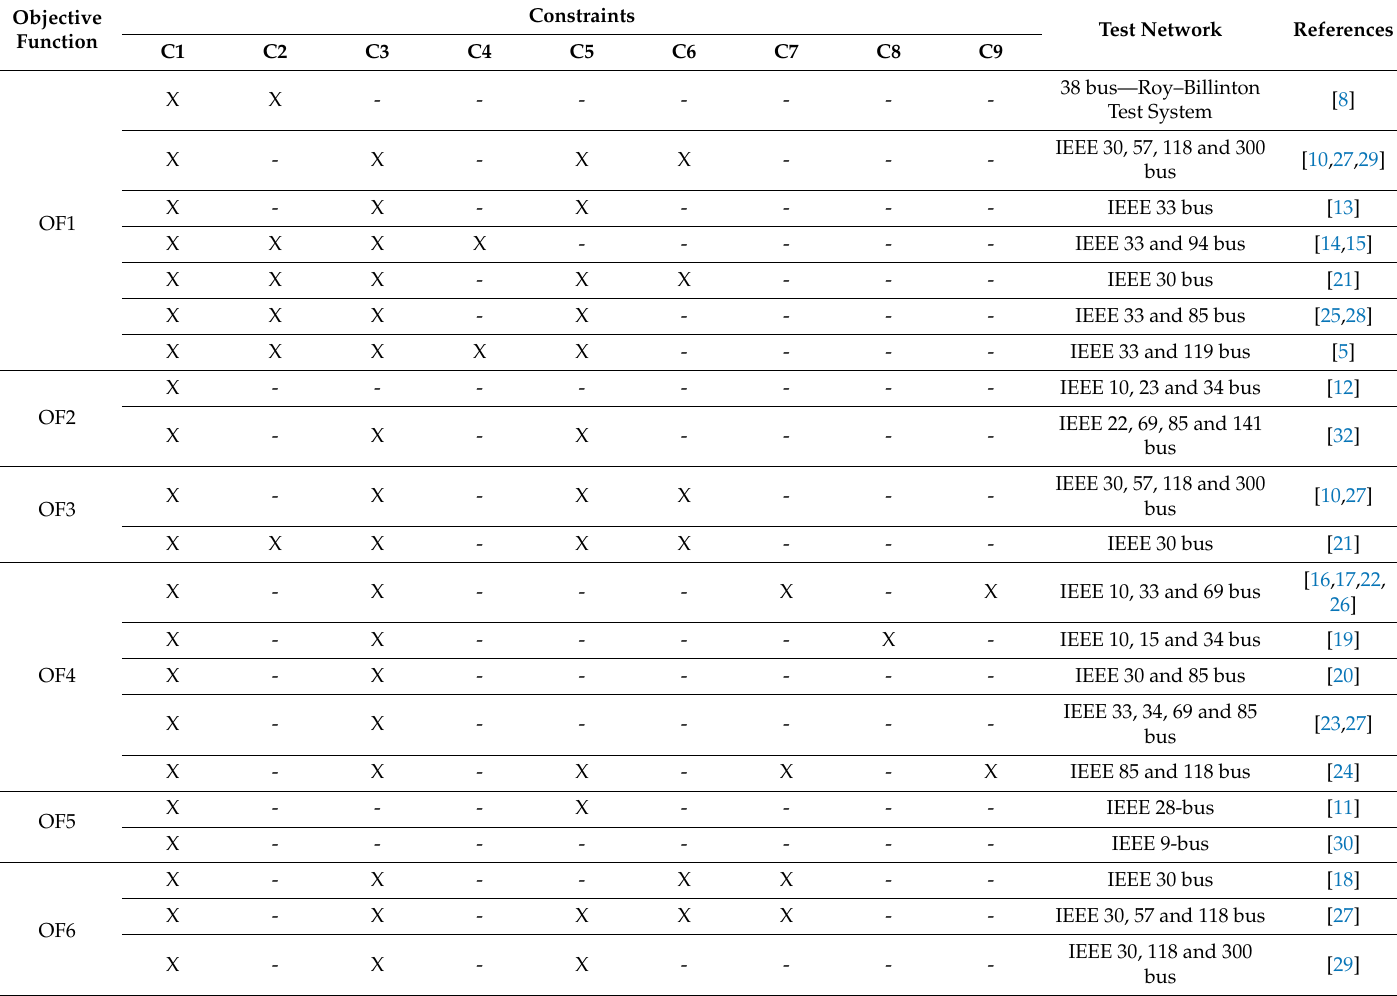
Table 1. Literature review regarding the capacitor allocation problem based on artificial